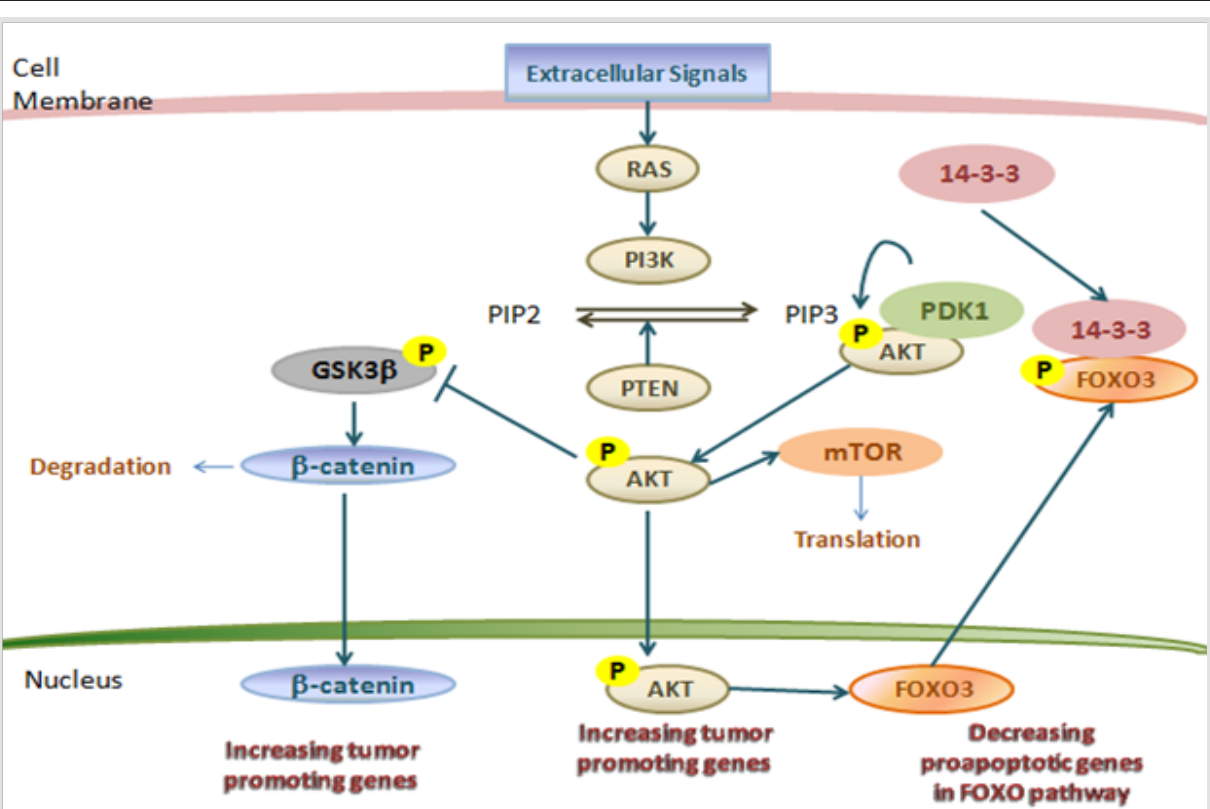
Figure 4. The PI3K–AKT and related pathways in thyroid cancer